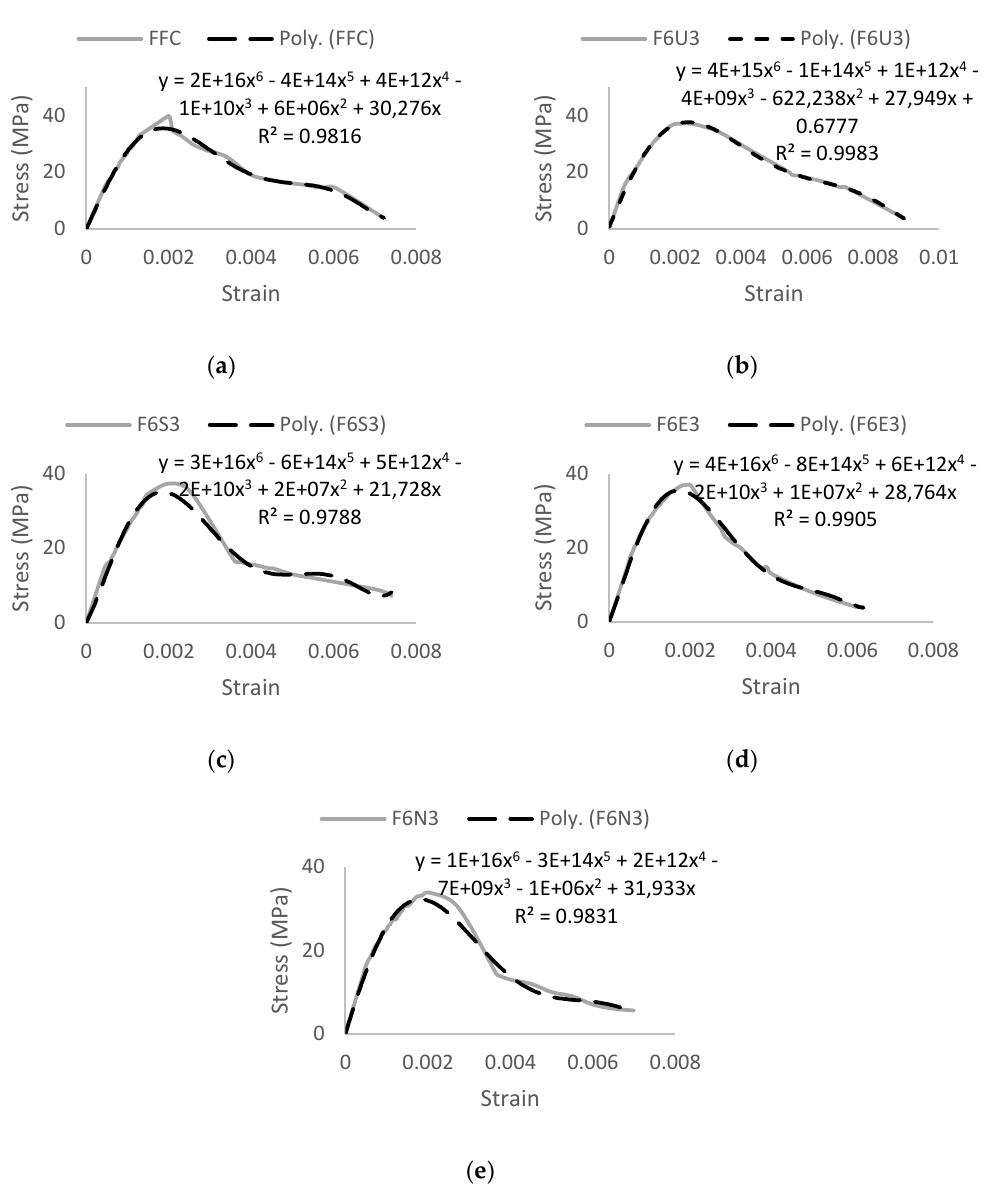
Figure 5. Uniaxial compression stress – strain curve: ( a ) FFC, ( b ) F6U3, ( c ) F6S3, ( d ) F6E3, ( e ) F6N3. The tensile strength of the HyFRC at 28-days was 1.96 MPa with a corresponding peak strain of 59 µε . In the elastic stage, a linear trend line with the equation y = 34,057x and a correlation factor, R 2 of 99.23% was used to model the pre post-crack behavior of the HyFRC. In the plastic stage, a sixth order polynomial curve with the equation y = − 1E + 11x 6 + 1E + 10x 5 − 4E + 08x 4 + 7E + 06x 3 − 66,421x 2 + 212.77x + 0.375 was adopted to obtain the best polynomial curve in modelling the strain-softening mode of failure. The correlation factor, R 2 for this polynomial trend line curve is in the range of 99.24% as shown in Figure